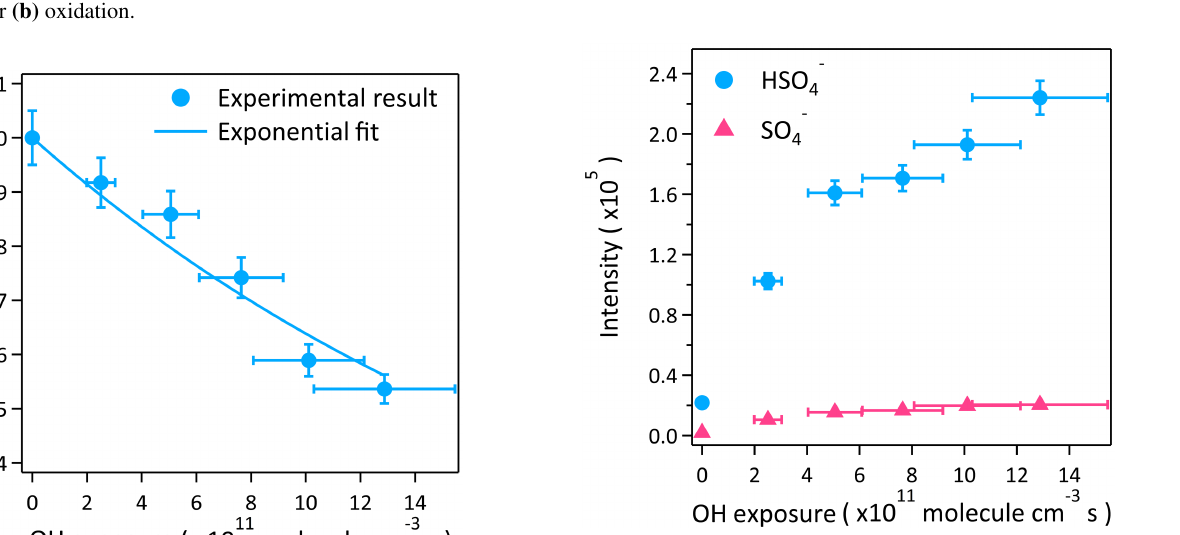
Figure 7. The kinetic evolution of carbonyl (C 2 H 3 SO 5 − ) and al- cohol (C 2 H 5 SO 5 − ) functionalization products as a function of OH exposure in the heterogeneous OH oxidation of sodium ethyl sulfate. The small uncertainty in ion intensity measurement for C 2 H 5 SO 5 − is not visualized in the figure.